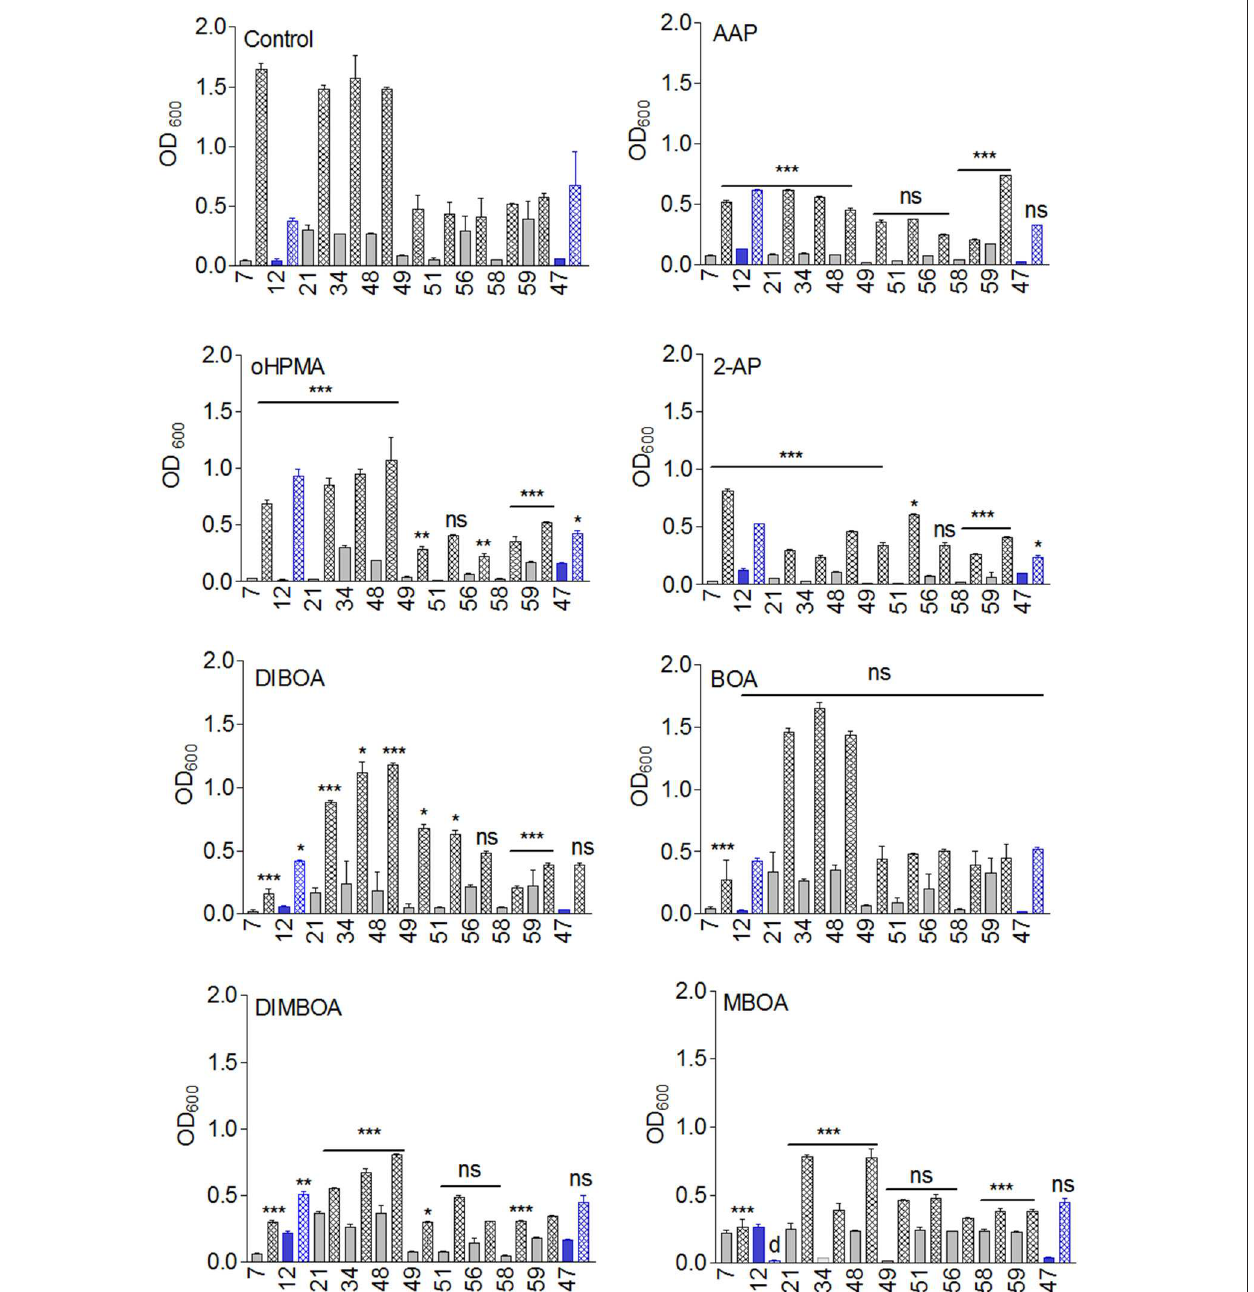
FIGURE 2 | Growth of the microorganisms in the presence of 7.5 µ mol DIBOA, DIMBOA, BOA, MBOA, AP, AAP, and oHPMA and control ( n = 5). Ns, not significant; * p < 0.05; ** p < 0.005; *** p < 0.0005). Microorganisms: Mycobacterium fortuitum (7), Bacillus aryabhattai (34), Bacillus cereus (59), Bacillus megaterium (21, 48), Bacillus methylotrophicus (58), Lysinibacillus xylanilyticus (56), Paenibacillus polymyxa (51), Aminobacter aminovorans (49), the fungi Papulaspora sepedonioides (12), and Trichoderma viride (47) . Blue bars, fungi; gray bars, bacteria; OD 600 culture start, ; OD 600 after 72h,